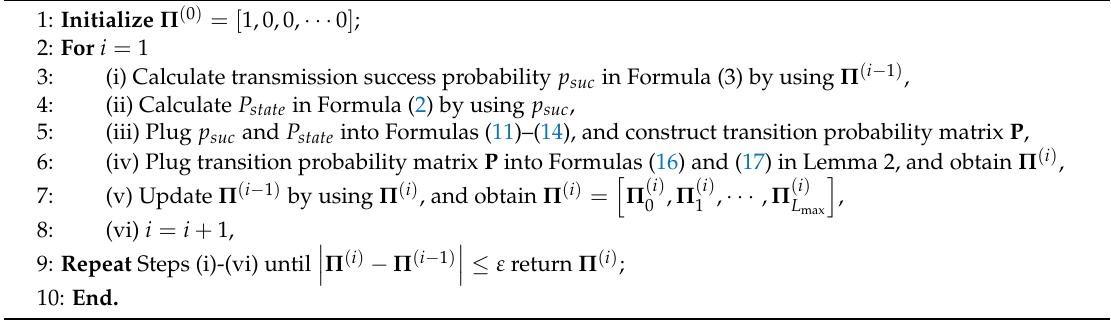
Algorithm 1: A fixed point iteration method to calculate the steady-state probability